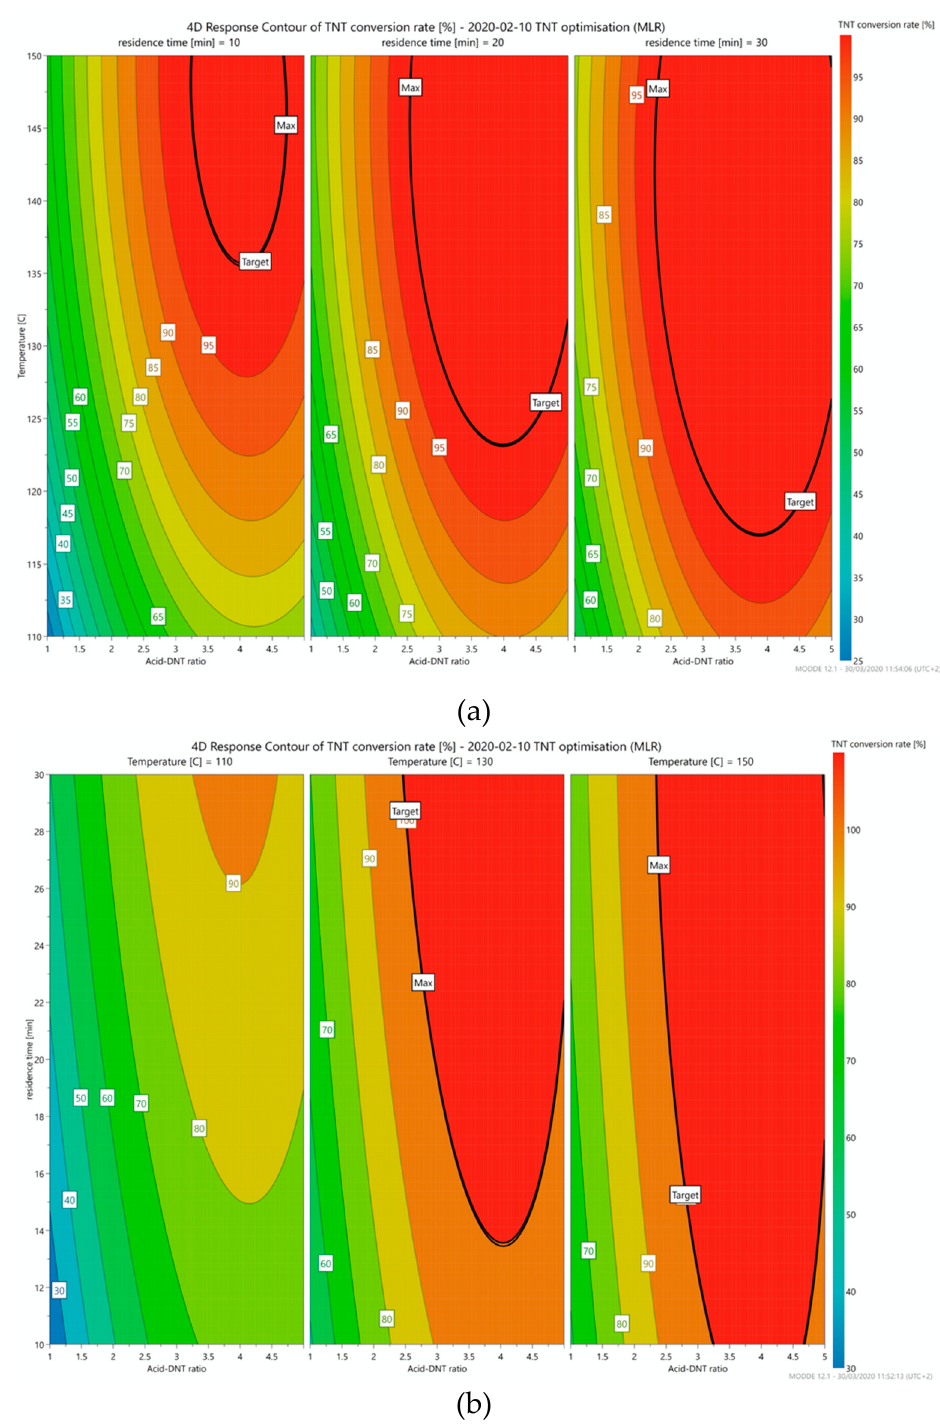
Figure 2. ( a ) Conversion rates in relation with temperature and HNO 3 :DNT molar ratio at 10, 20, and 30 min residence time and ( b ) conversion rates in relation with residence time and HNO 3 :DNT molar ratio at 110, 130, and 150 °C.